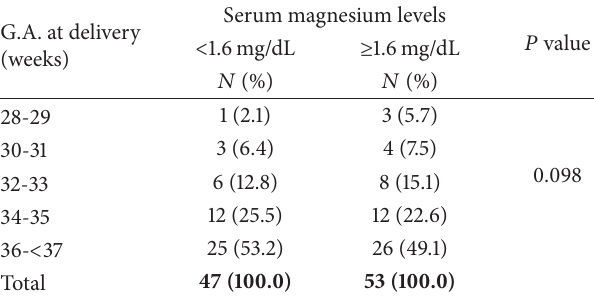
Table 5: Relationship between serum magnesium and gestational age for women with preterm delivery.